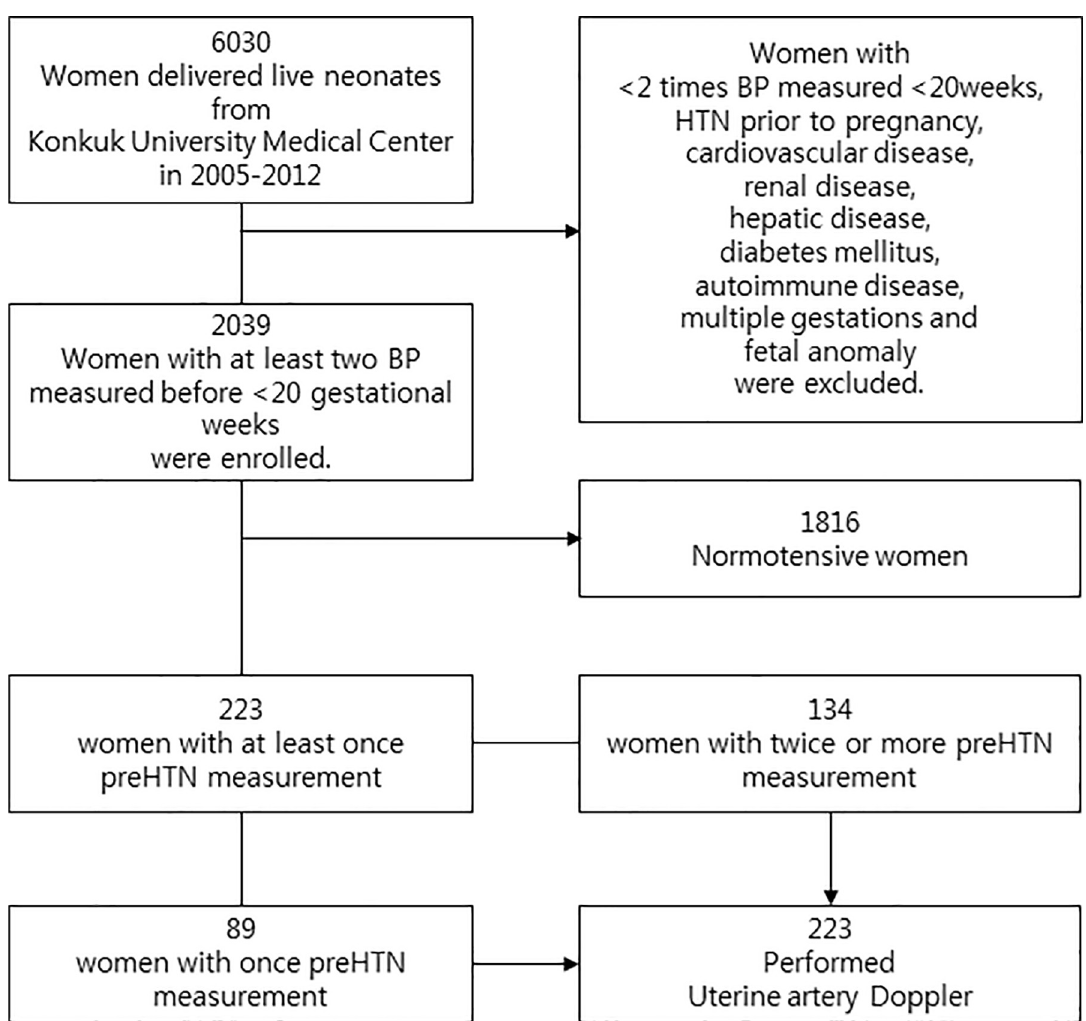
Fig 1. Flow diagram of women and excluded criteria in present study. Total 2039 singleton women who had blood pressure measured > 2 times or more before 20 gestational weeks in Konkuk University Medical Center were enrolled. Uterine artery Doppler was performed in all patients in the prehypertension (preHTN) group (n =